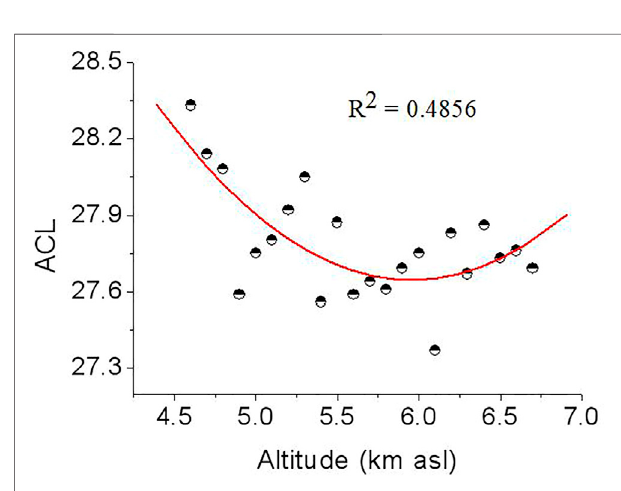
FIGURE 5 | Plot of δ 13 C versus altitude for the analyzed sediment samples from Gongga Mountain in the Sichuan Basin.